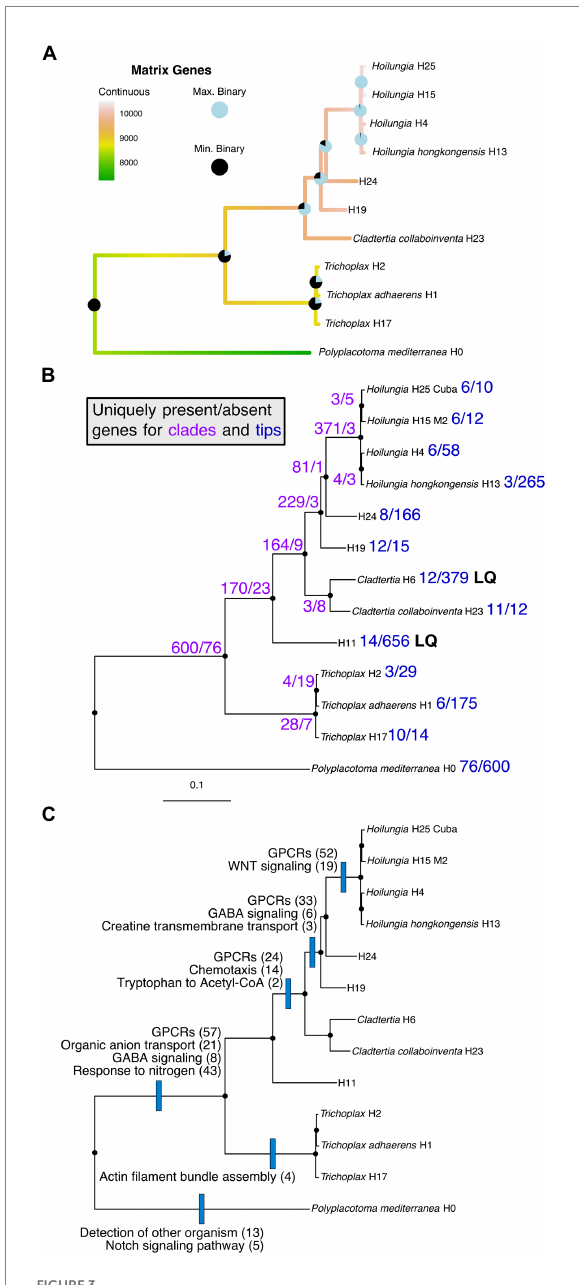
FIGURE 3 (A) Ancestral state reconstructions (continuous and sum of binary analyses) mapped onto the phylogenomic likelihood subtree containing most known clades of Placozoa. Binary reconstructions were conducted for each of 15,849 genes, and are depicted as pie charts ranging from the minimum number of genes found for any node to the maximum number found for any node. Only data from genomes with ≥ 90% BUSCO scores (complete + fragmented) were used for this analysis to avoid inflated absence data for lower-quality genomes (other tips were trimmed from the phylogenomic likelihood tree). This removed placozoan lineages H6 and H11. (B) The full Placozoa likelihood subtree with the numbers of uniquely present or uniquely missing genes found for each clade or tip. LQ = low quality (see BUSCO scores in Table 1). (C) The full Placozoa likelihood subtree with the names and numbers of functional genetic groups enriched among uniquely present orthologs. Functional enrichment is based on GO